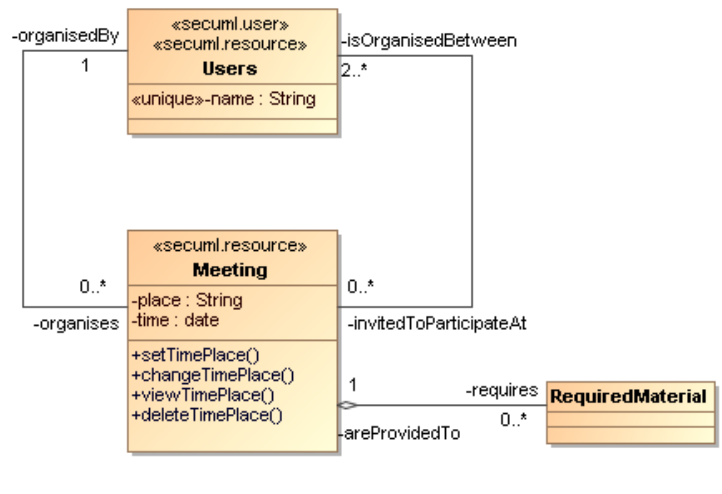
Figure 7. Logical Data